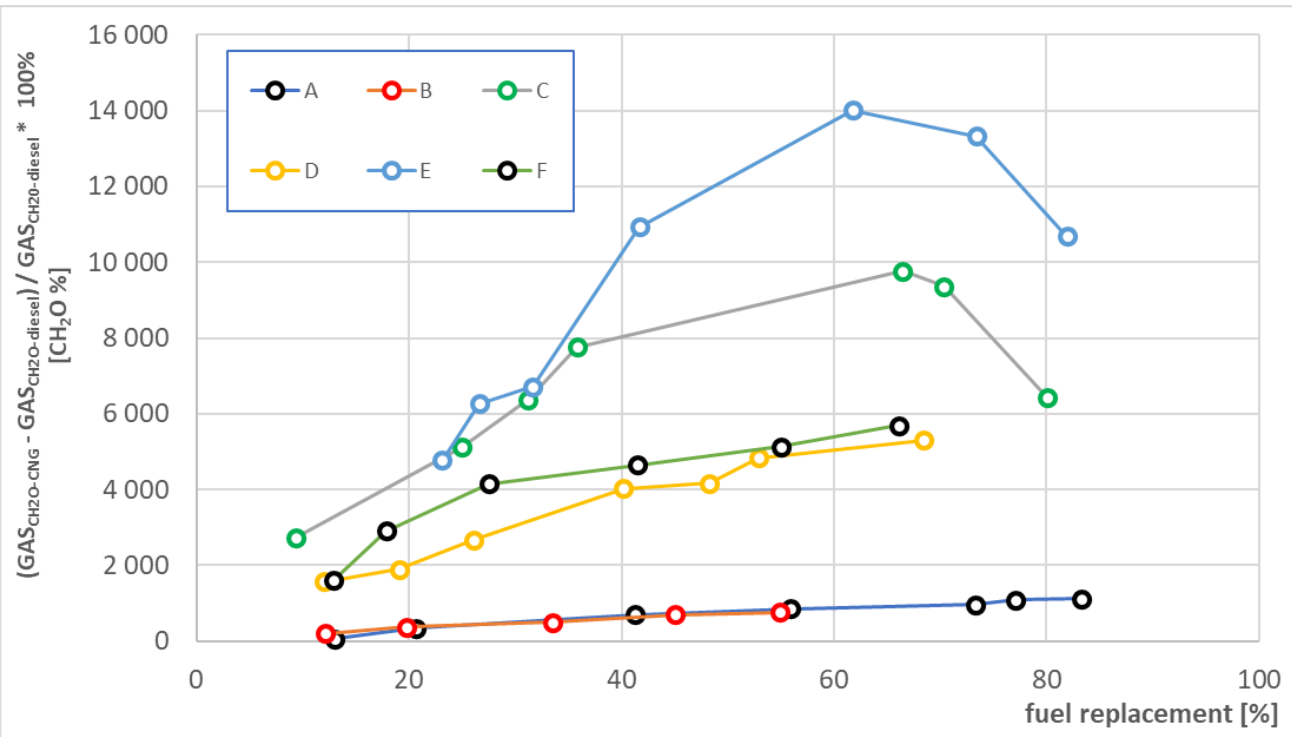
Figure 22. Curves from A to F showing the changes in the emission of formic formaldehyde as the comparison of exhaust gas temperature noted only in single fuel (diesel) working mode for individual engine operating points, where the rotation speed, power, and torque were constant, as a dual-fuel mode (where engine uses CNG and diesel fuel) replacement function.